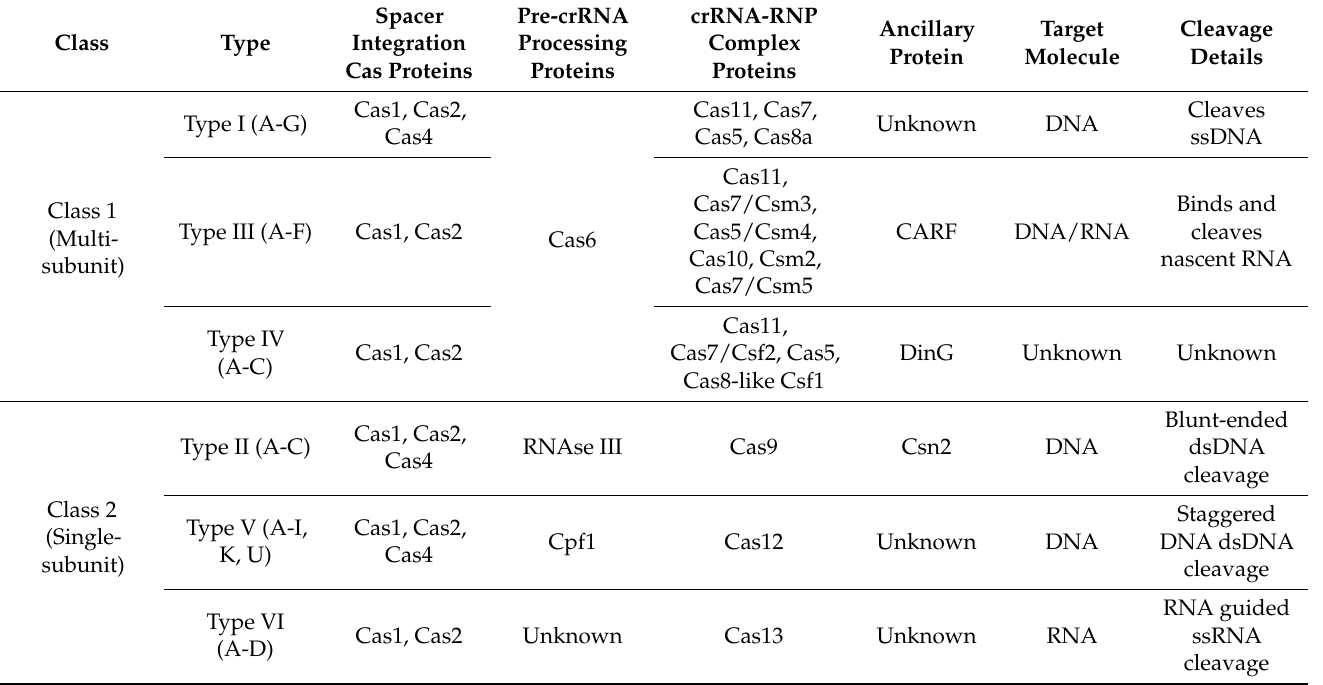
Table 3. Classification and characterization of CRISPR Cas system